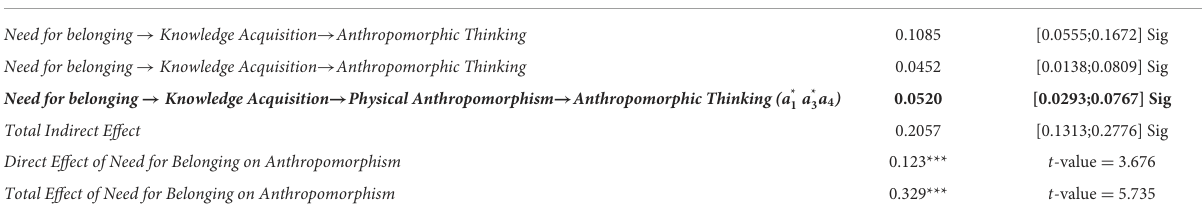
TABLE 6 Direct, indirect, and total effects of the need for belonging on anthropomorphism.